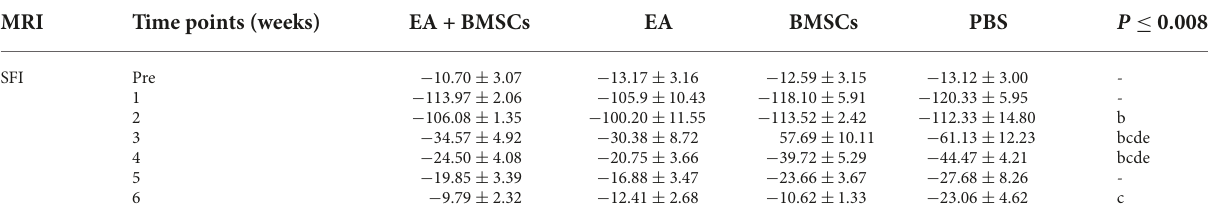
TABLE 5 SFI values in EA + BMSCs, EA, BMSCs, and PBS (mean ± SD).